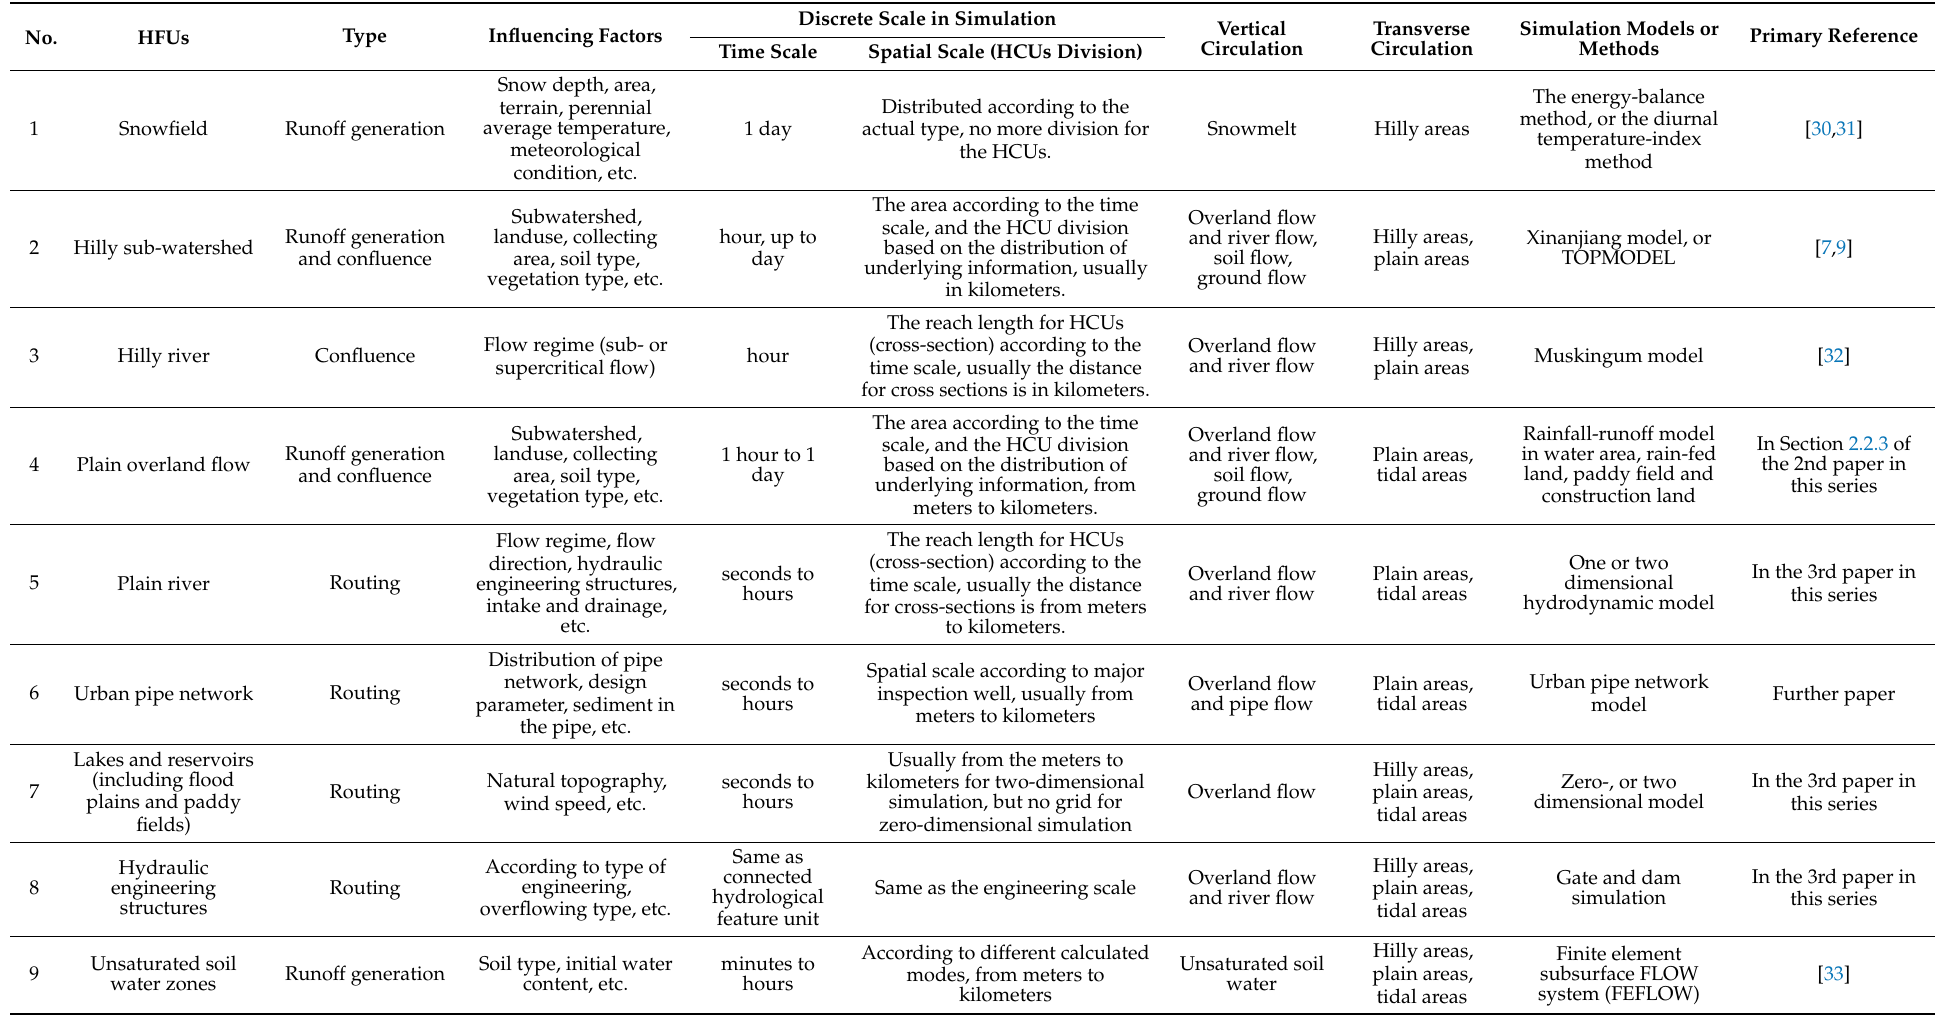
Table 1. Typical hydrological feature units (HFUs) in a